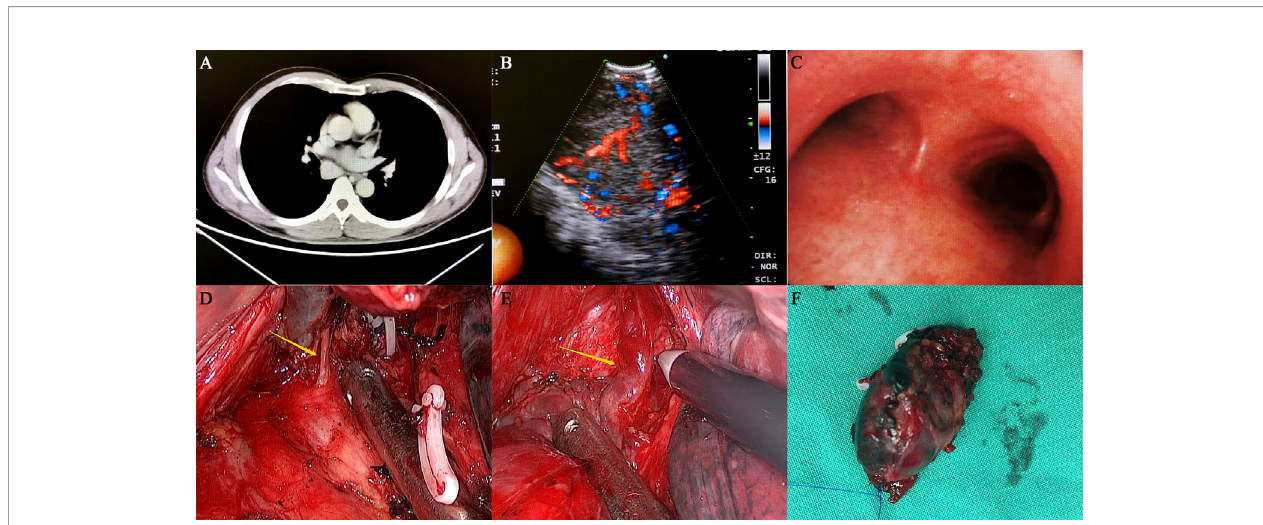
FIGURE 1 | Preoperative examination and intraoperative status of the patient. (A) The thoracic contrast-enhanced CT showed that the mass was located in the right posterior mediastinum, and its size was approximately 40*35 mm. The CT value of the plain scan was approximately 46 HU, and the CT value was approximately 130 HU after enhancement. (B , C) Endobronchial ultrasonography showed that a posterior mediastinal mass was located far from the carina with a complete capsule, clear margin and adequate blood supply. (D , E) During the operation, the lesion was located under the carina and surrounded by several abnormally large bronchial arteries, which had an extremely abundant blood supply. (F) The mass was completely removed and was approximately 3.5 cm in